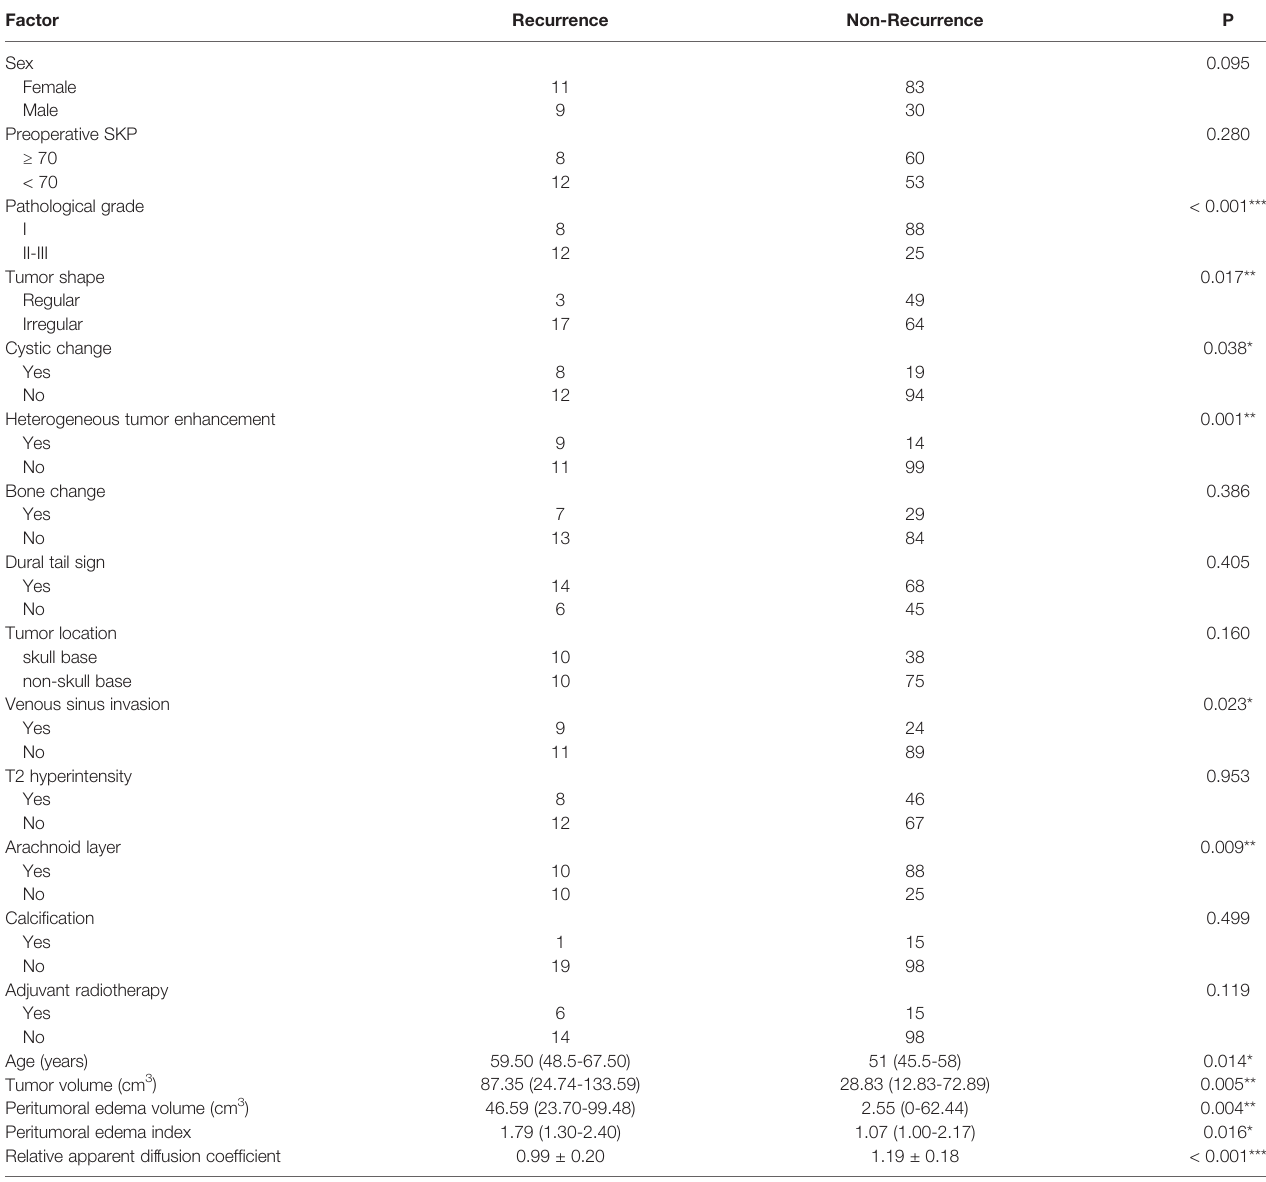
TABLE 1 | Patient characteristics and univariate analysis of the risk of